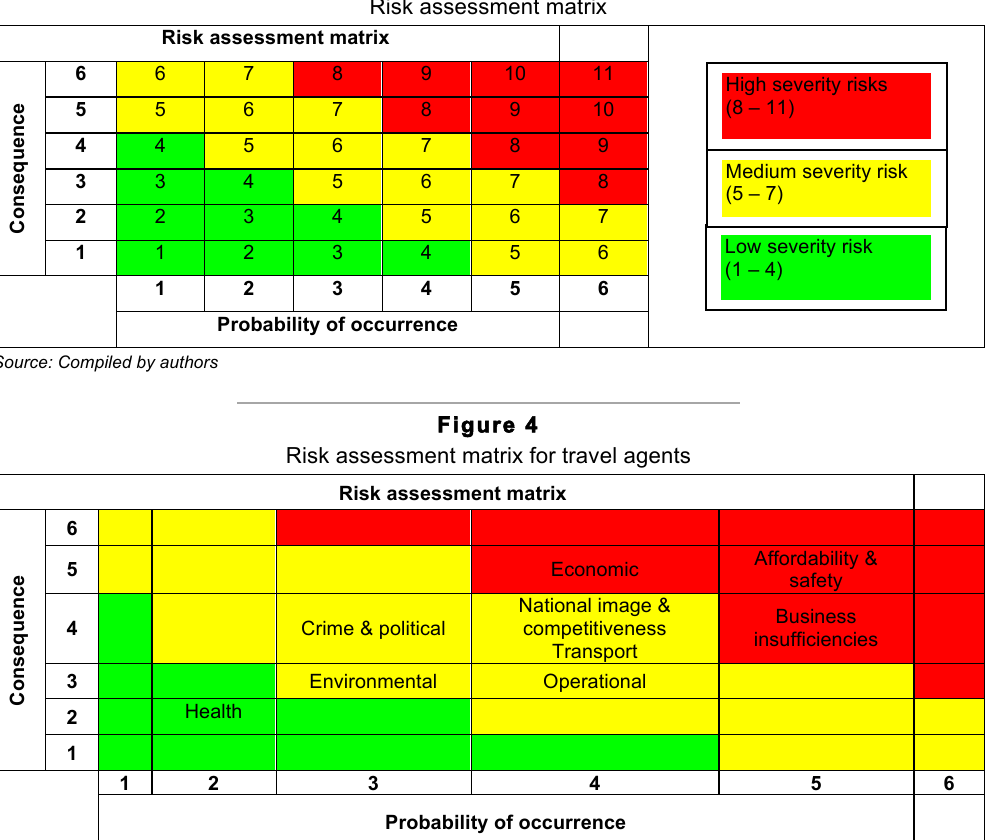
Risk assessment matrix